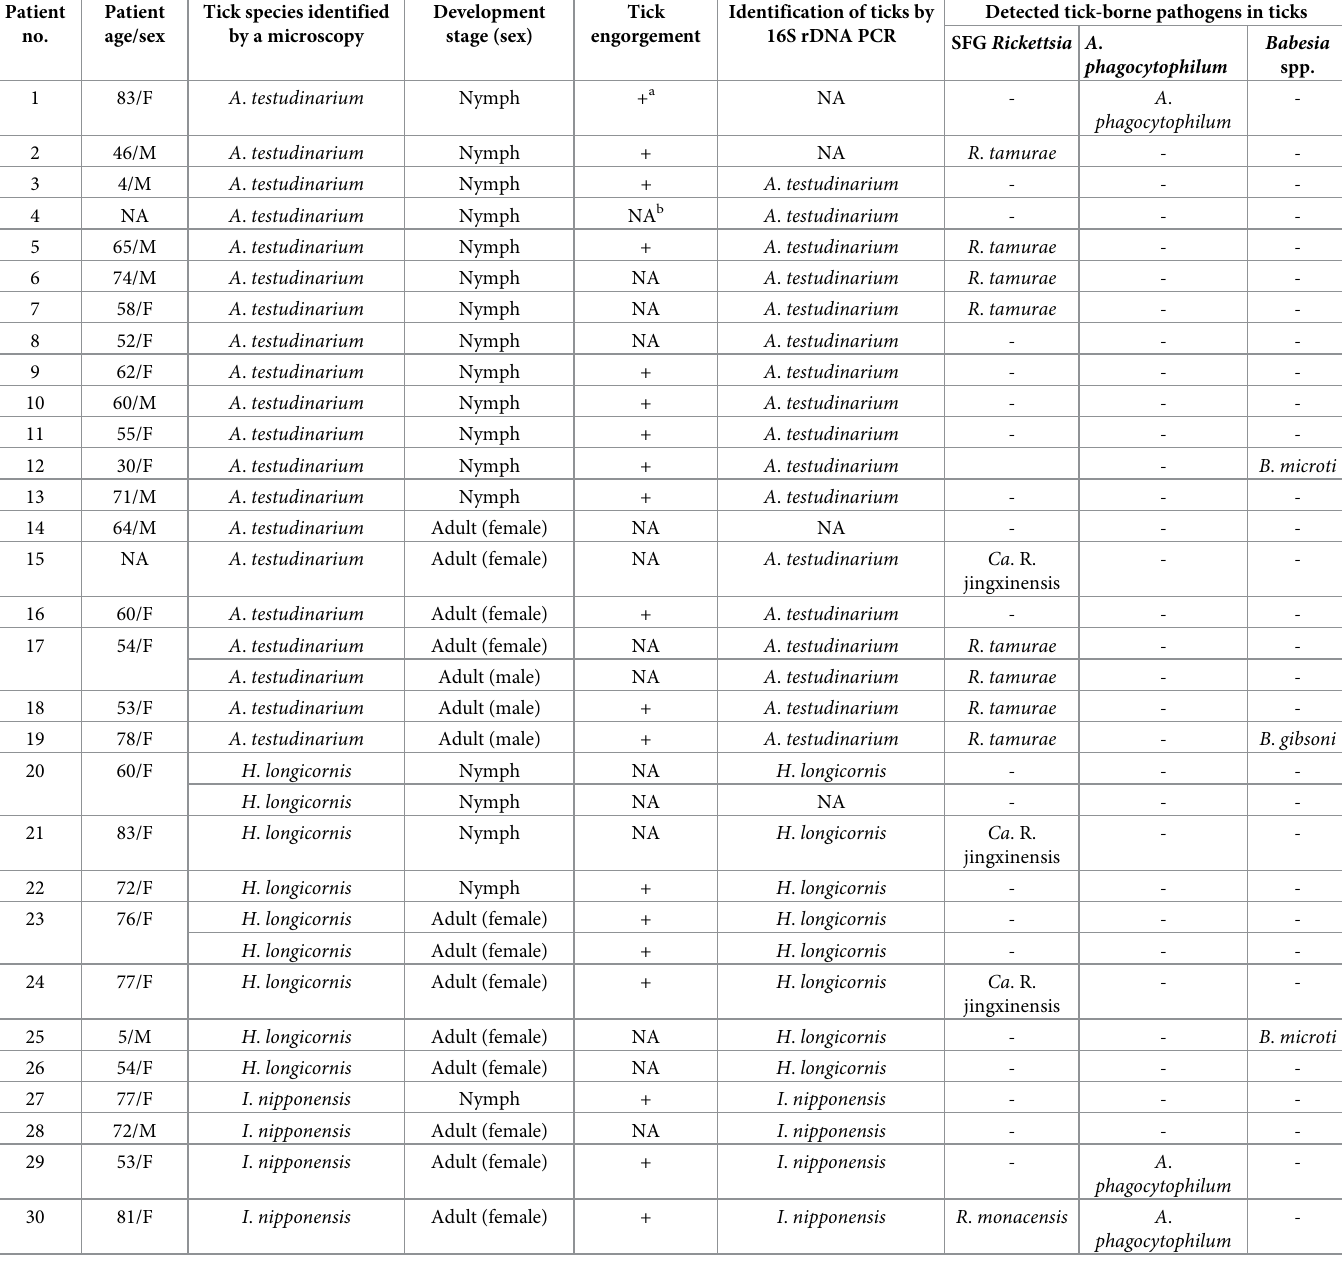
Table 3. Characteristics of the 33 ticks using the DNA of tick-borne pathogens obtained from tick-bitten humans. Patient